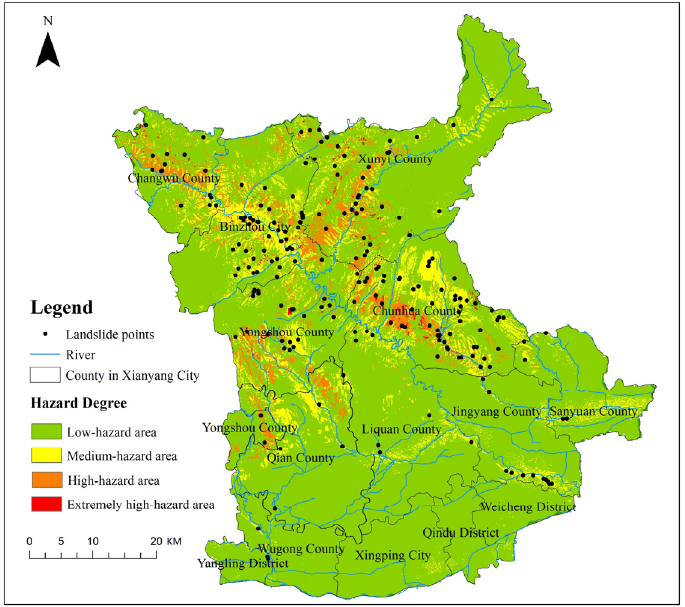
Figure 9. Landslide hazard assessment zoning map of Xianyang City. Table 6. Area and proportion of each dangerous